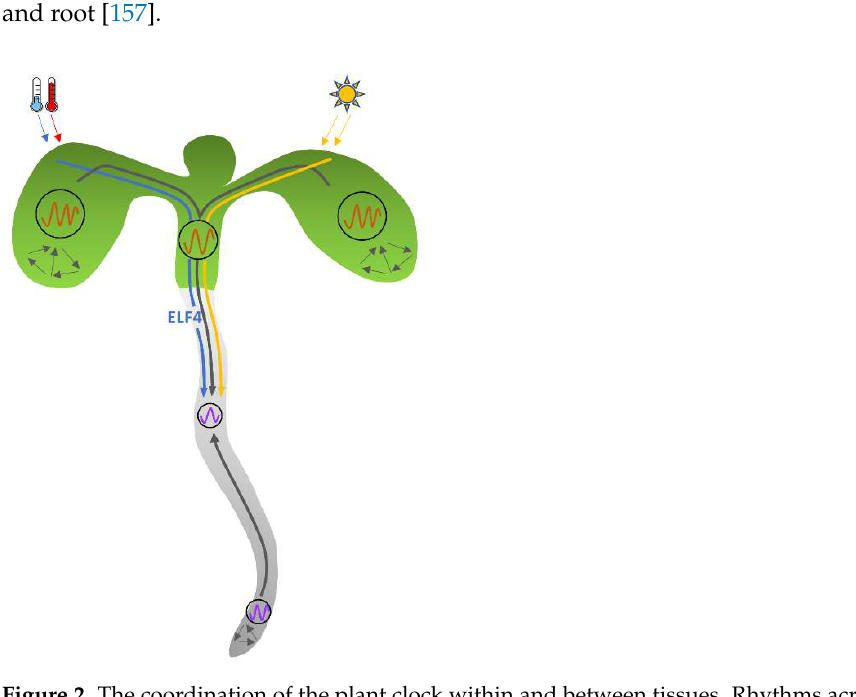
Figure 2. The coordination of the plant clock within and between tissues. Rhythms across the plant exhibit tissue specific phases and periods. Single cell imaging suggest local cell-to-cell coupling (indicated by short gray arrows pointing to each other) and long-distance coordination of clock by spatial waves of clock gene expression (indicated by long gray arrows). Tissue-grafting experiments show that shoots from wild-type plants restore the period in roots of arrhythmic clock mutants. ELF4 can move from shoots to roots to influence the root clock. Low temperature enhances ELF4 trafficking, which results in the lengthened circadian period, whereas high temperature inhibits ELF4 movement, shortening the period in roots (the blue arrow in Figure 2 indicates shoot-to-root movement of ELF4, which is enhanced by low temperature). Light piped from shoots has been also shown to entrain the root clock in seedlings (indicated by yellow arrow).